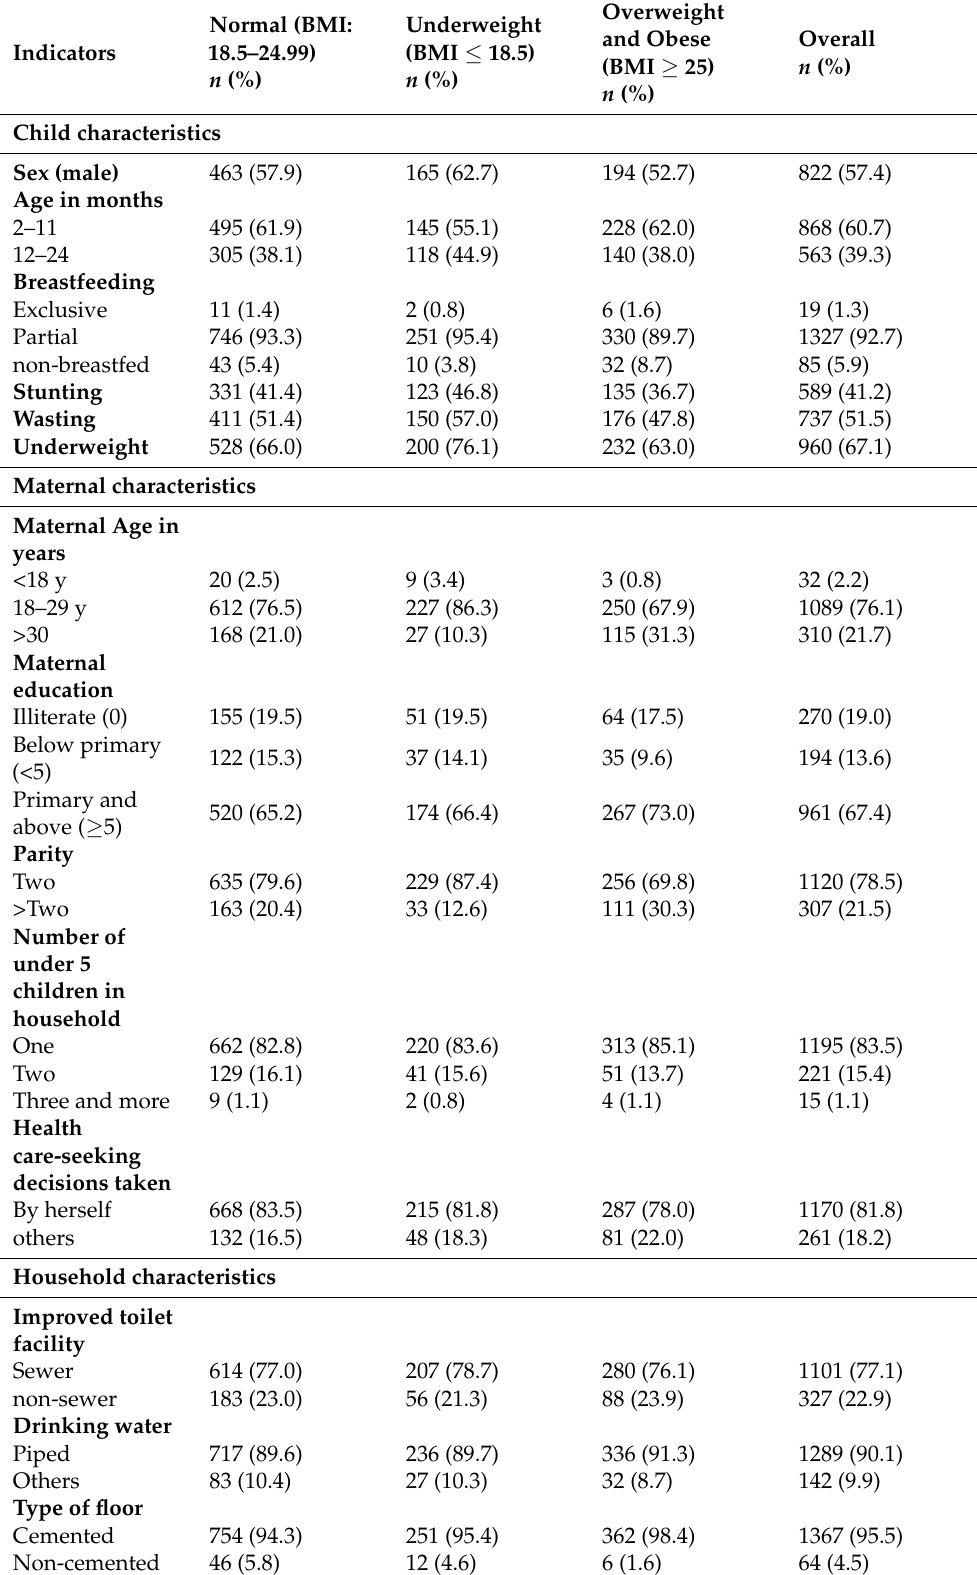
Table 2. General characteristics of the children by maternal